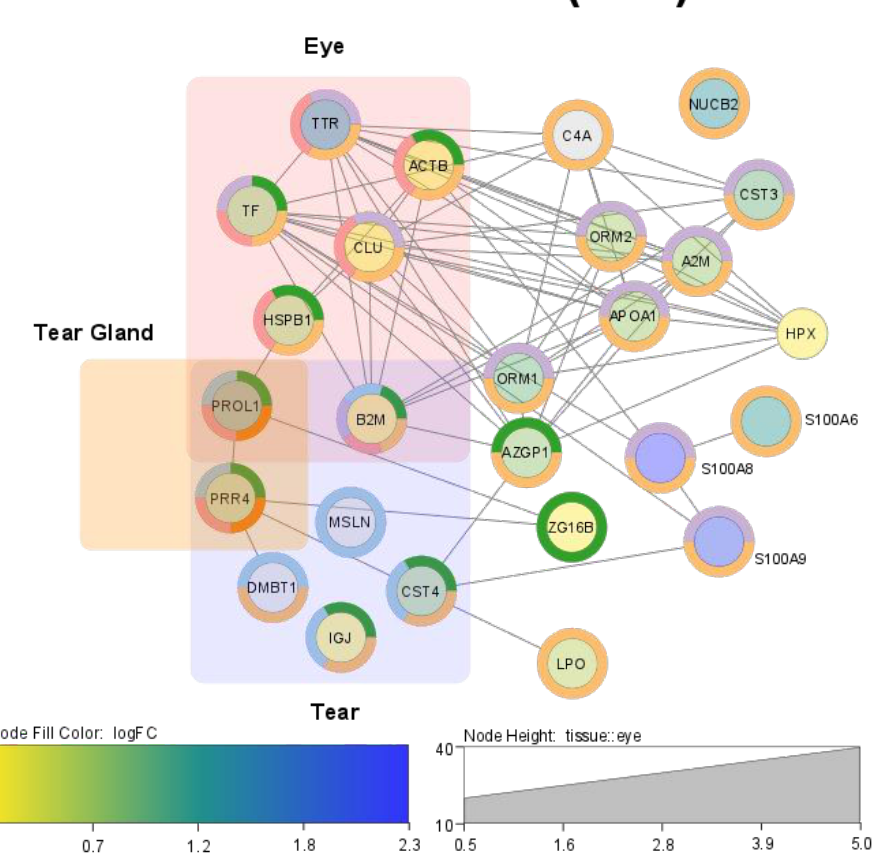
Figure 4. A map of critical interactions between the significantly different proteins. The map is reconstructed in the context of retinal vein occlusion (RVO) pathogenesis, tissue (source) specificity (such as tear gland, tears, and eye), and attributed with a quantitative property of measured proteins (color-scaled bar). The node height level indicates the confidence of protein interaction and normalized to eye-tissue specificity. Circle colors indicate the most prevalent biological processes that contribute to CRVO progression and are taken by mapped proteins (vesicle-mediated transport (magenta); defense response (cyan); retina hemostasis (green), regulation of immune system (orange), cell migration, and extracellular matrix organization (blue)). This figure has been produced in the Cytoscape software (version 3.8.2) for network data analysis, integration and visualization, and is